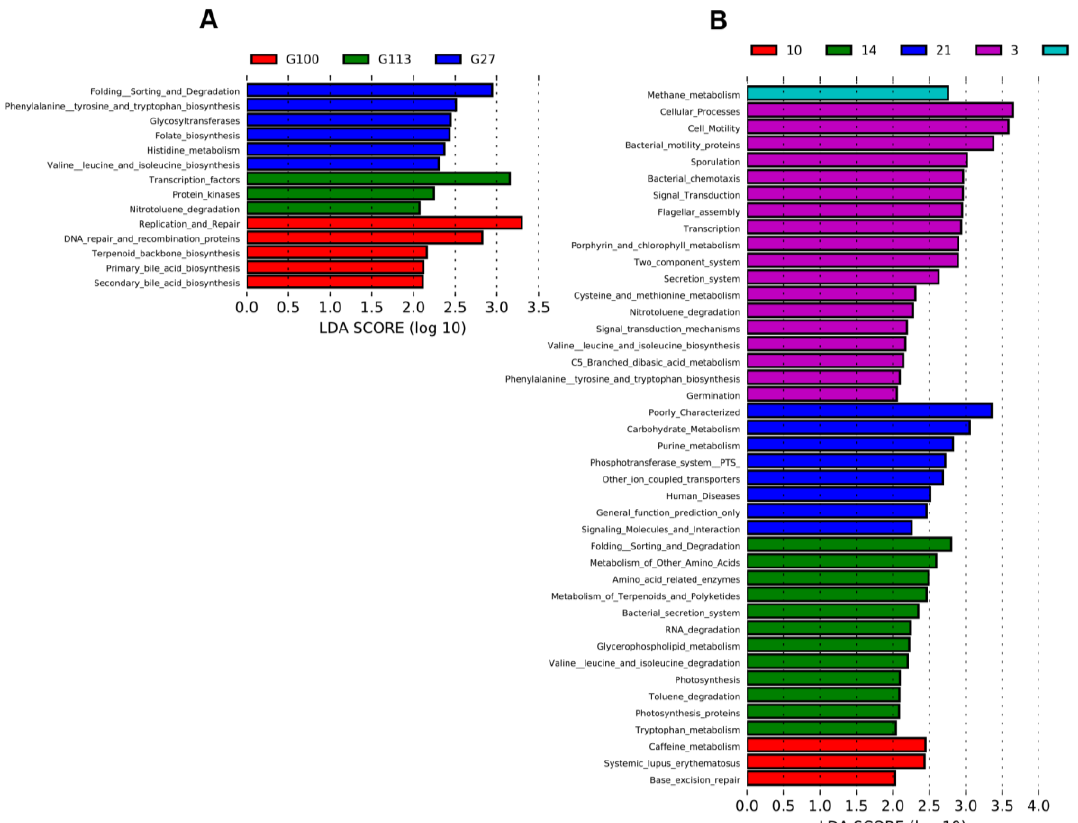
Figure 4. Perinatal bacterial function prediction. ( A ) The functional di ff erences of bacteria at di ff erent time points during the prenatal period; ( B ) the functional di ff erences of bacteria at di ff erent time points during the postnatal